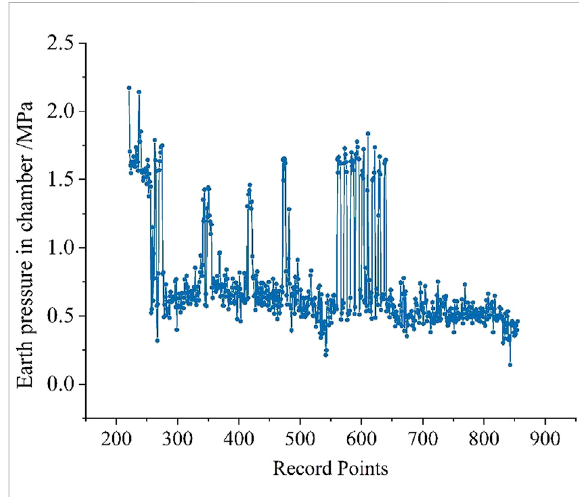
FIGURE 7 Distribution of the Earth pressure in chamber in sample data.